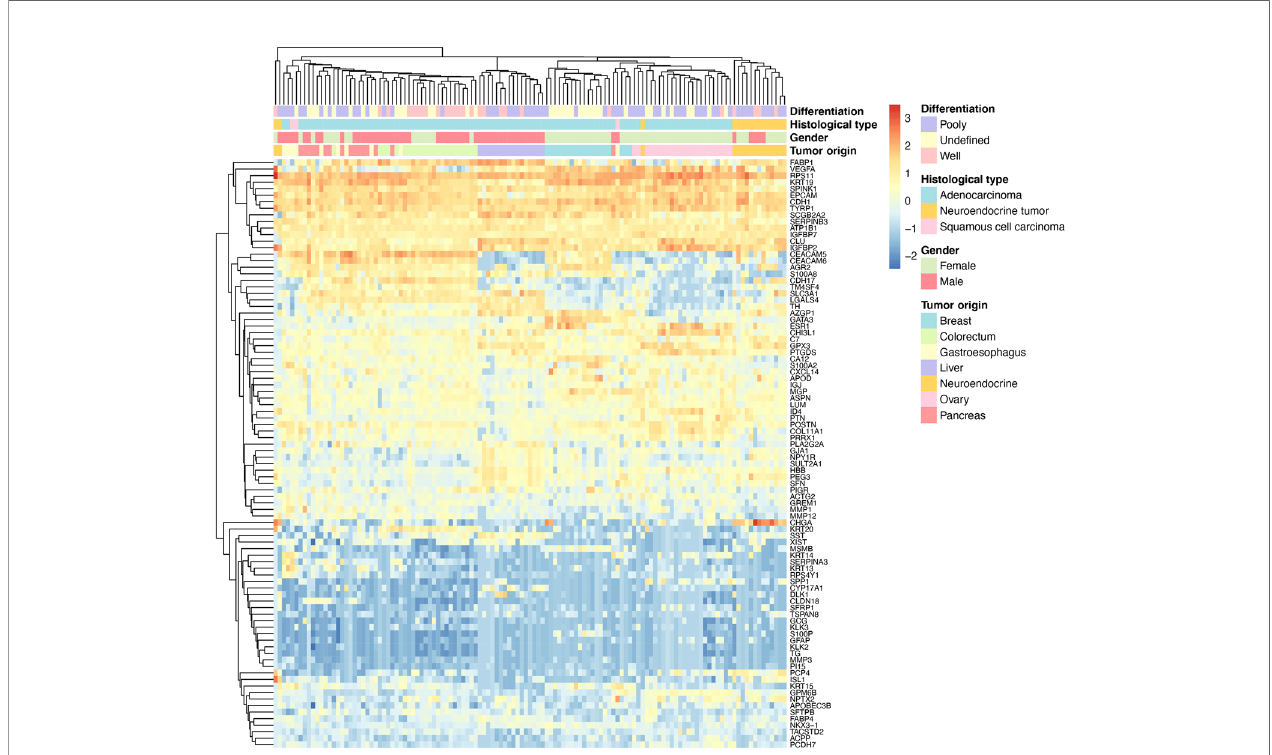
FIGURE 3 | Hierarchical clustering analysis of 90 genes in 123 specimens. The average linkage hierarchical clustering method was performed where the metric of similarity was Pearson ’ s correlation between every pair of samples. The left panel shows a dendrogram of hierarchical clustering of 90 genes. Colored pixels capture the magnitude of the gene expression intensities, where shades of blue and red represent under-expression and over-expression, respectively, relative to the mean for each gene. The upper panel shows a dendrogram of hierarchical clustering of samples. The clinical features such as degree of differentiation, histological types, gender and tumor types of each sample are indicated in the upper panel. The number of tumor types less than fi ve are not